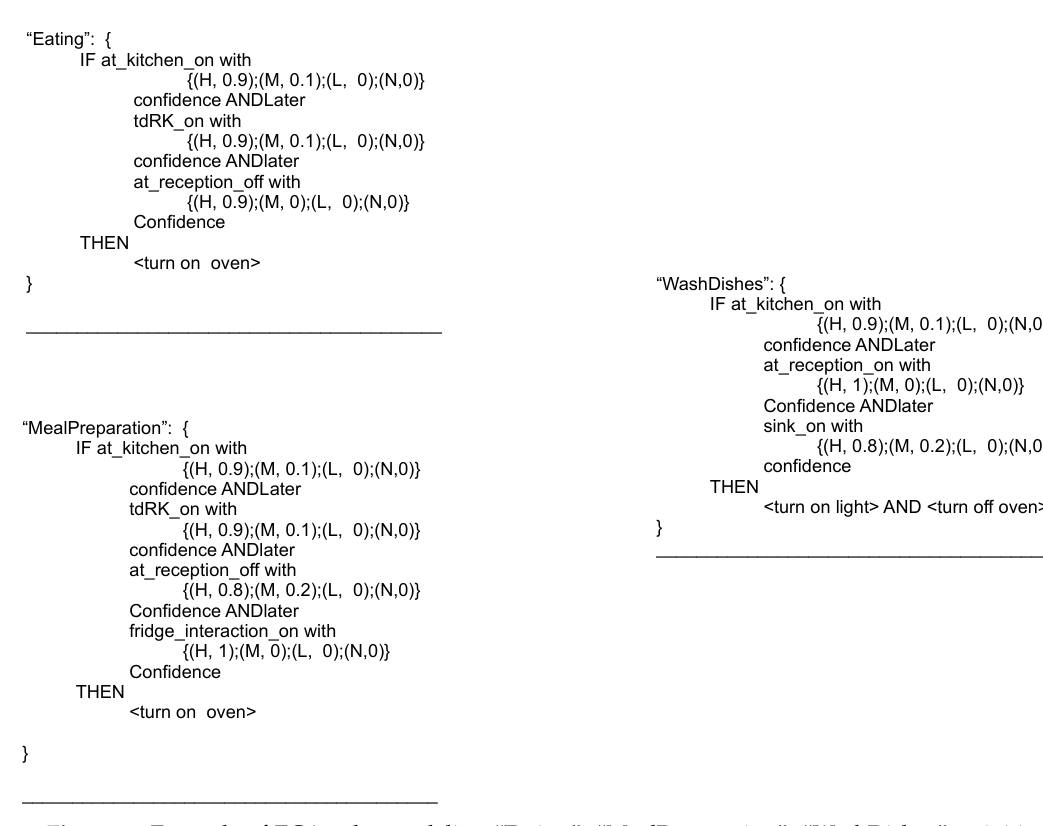
Figure 6. Example of ECA rules modeling “Eating”, “MealPreparation”, “WashDishes” activities. Pictures inspired by AUG - ECA [9].